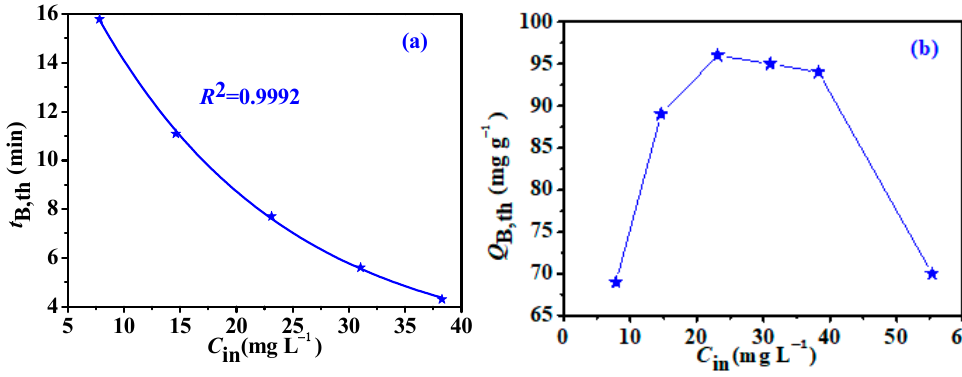
Figure 10. Effect of inlet concentration on t B,th ( a ) and Q B,th ( b ). Bed temperature is another important factor that affects the L2 adsorption